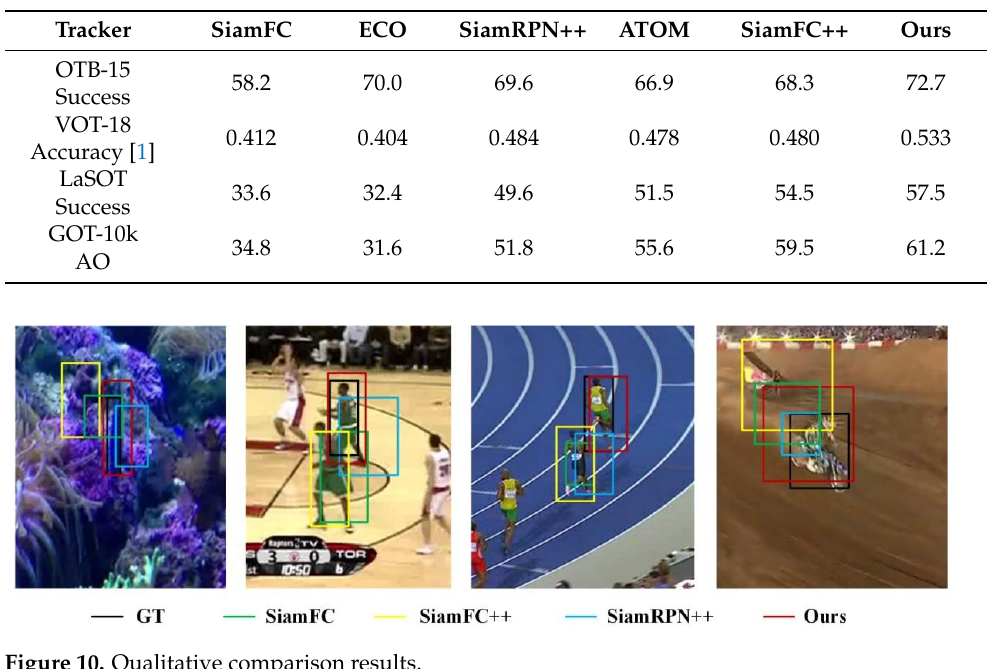
Table 4. Results on several benchmarks.